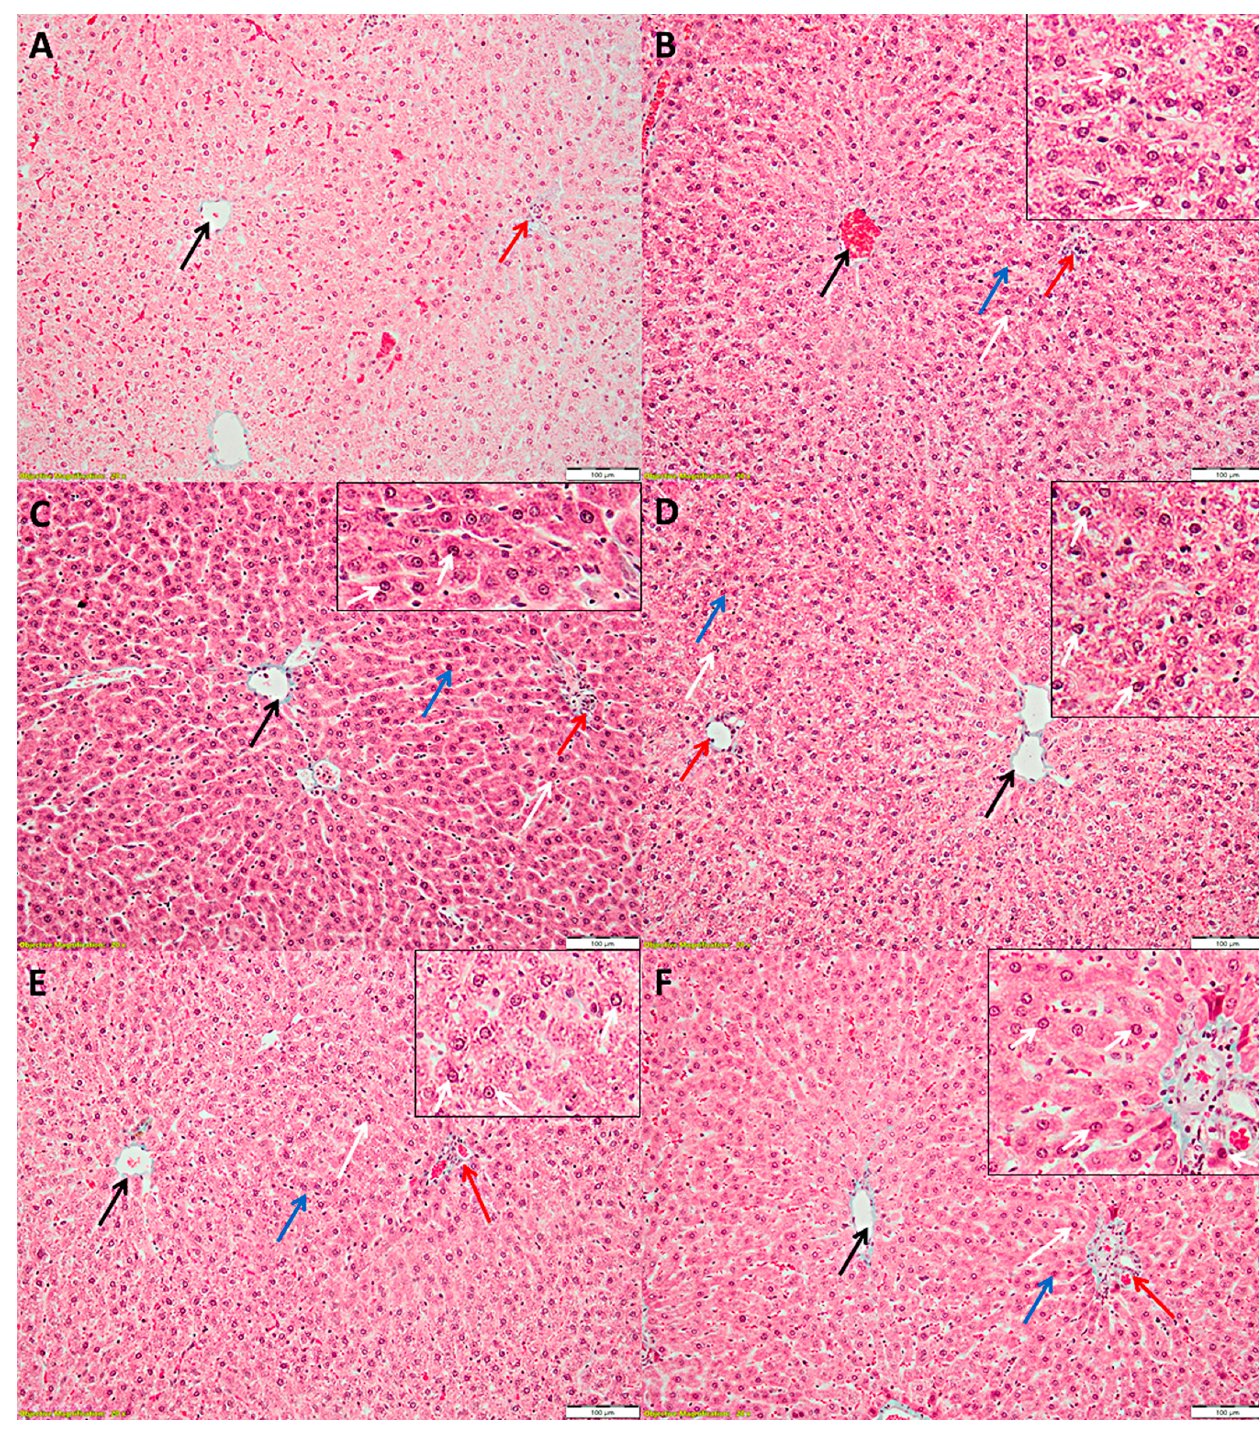
Figure 4. Hepatic lobes; ( A )—Control (C) group; ( B , C )—gentamicin (G) group; ( D )—G-EGCG group; ( E )—G-LEGCG group; ( F )—G-Sily group, where EGCG = epigallocatechin gallate, LEGCG = liposomal epigallocatechin gallate, Sily = silymarin. The images were taken with a 20× lens and the scale bar is 100 μ m. Black arrow—centrilobular vein; red arrow—porto-biliary space; blue arrow—hepatocytes with intensely stained cytoplasm; white arrow—thickened nuclear membrane. Most hepatocytes had a normal appearance in the G-Sily group. Only a few hepato- cytes from the outer third of the liver lobes appeared with more intensely stained cyto- plasm, and some hepatocytes had a slightly thickened nuclear membrane (Figure 4F).